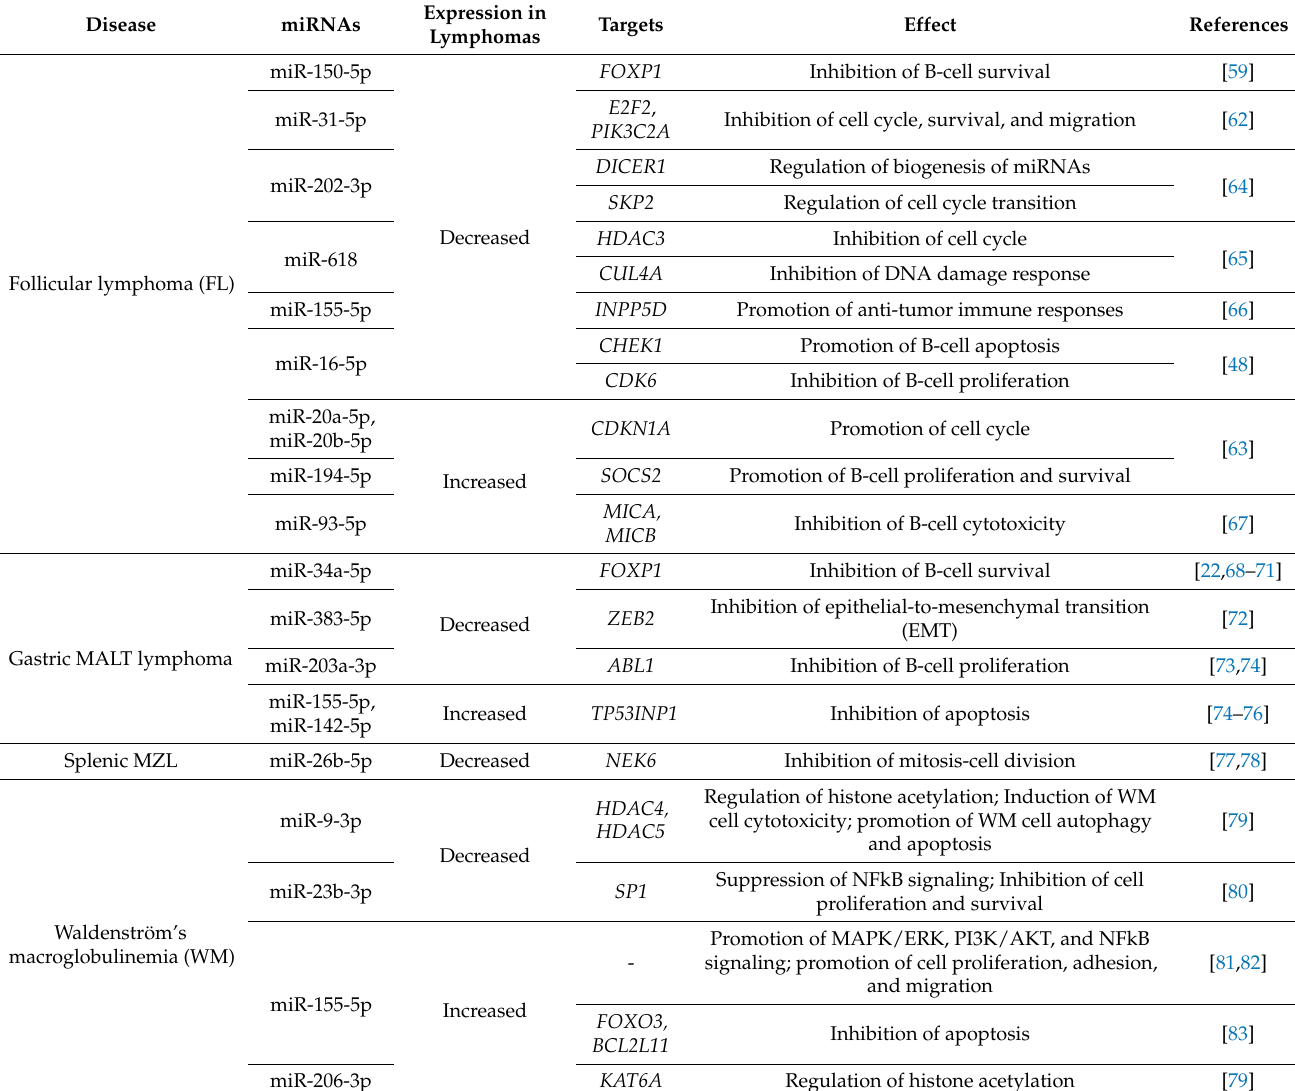
Table 1. miRNAs with a regulatory effect in indolent B-cell non-Hodgkin lymphomas (NHLs).